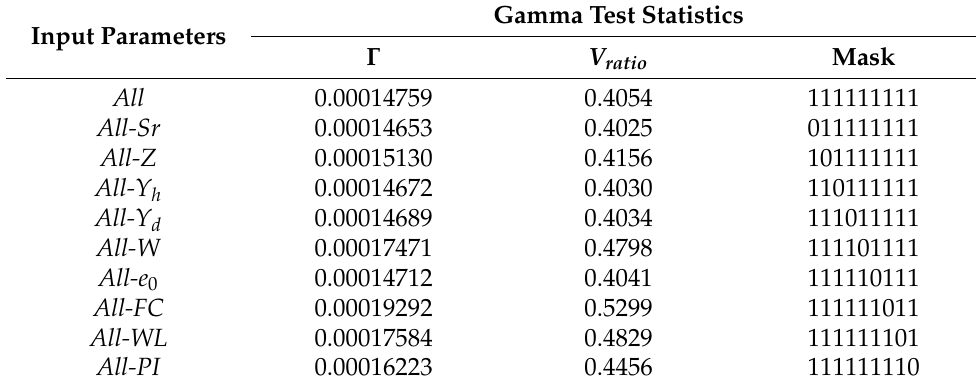
Table 7. Optimal input variable nomination using GT.